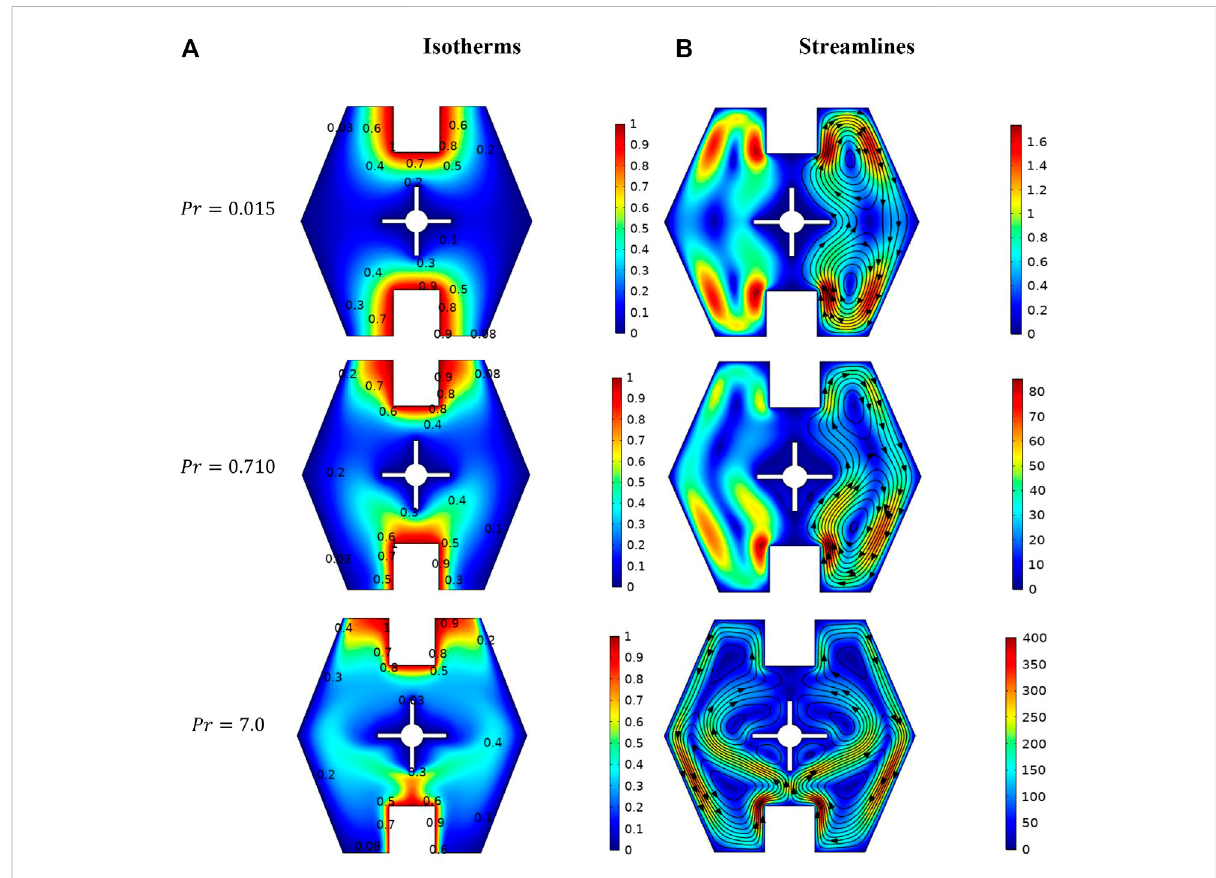
FIGURE 5 (A,B) Isotherms (left) and streamlines (right) for the variation in Pr at Ra (cid:2) 10 3 and Da (cid:2) 10 − 3